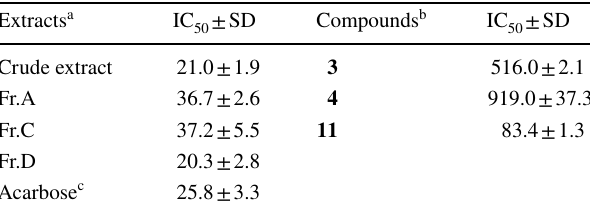
Table 3 α-Glucosidase inhibitory activities of extracts and com- pounds from M. haplocalyx